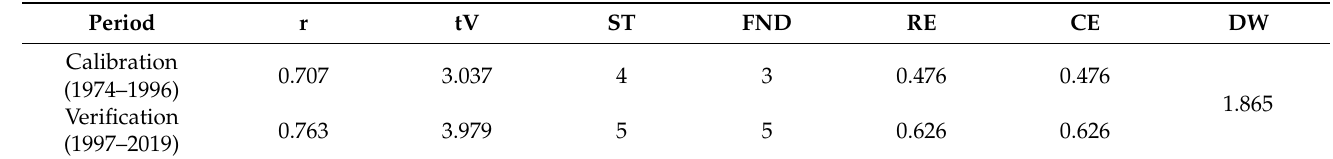
Table 3. Statistics for the validation process of the seasonal SPEI from February to May of the current growth year.